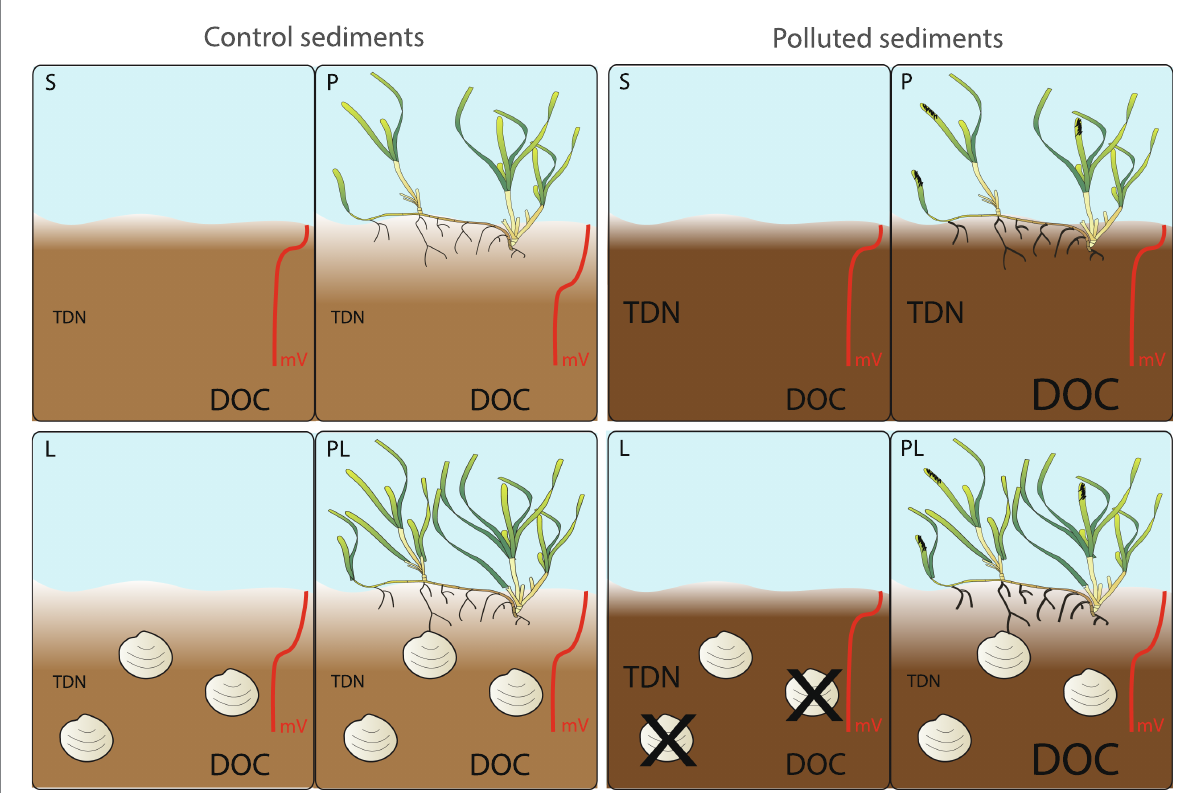
FIGURE 6 Conceptual model of facilitation of the seagrass Cymodocea nodosa by the lucinid clam Loripes orbiculatus , in control (left) vs. polluted (right) sediments. (S) represents pots with only sediment; (P) are pots with seagrass; (L) are pots with lucinids; (PL) represents pots with the plant and lucinids. Presence of lucinids resulted in increased above-ground biomass (more leaves) irrespective of the sediment type. Conversely, root apical growth (thicker roots) increased in polluted sediments, regardless of lucinid clams. Lucinid mortality was high in the polluted sediment (black crosses), but only when the plant was absent, while the percentage of plant necrotic tissue (black markings on leaves) were higher in the polluted sediment regardless of lucinids. The interaction of plants and lucinids significantly improved sediment conditions as shown by the increase in redox potential (mV) and decrease (consumption) of total dissolved nitrogen (TDN) in the polluted sediment, where the plant released large quantities of dissolved organic carbon (DOC). Seagrass symbol credit: Integration and Application Network